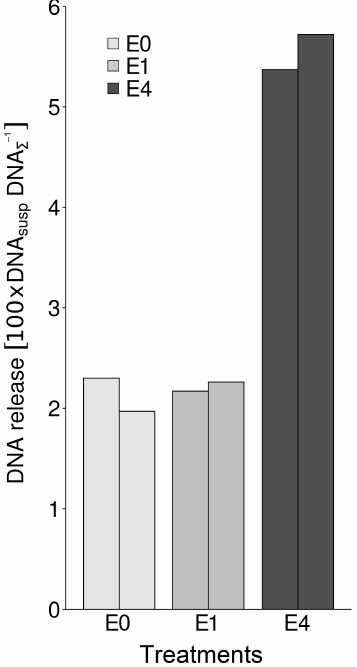
Figure 3. Relative bacterial DNA release from soil aggregates after treatments E0, E1 and E4 defined as 100 × ratio of bacterial DNA from suspended cells (DNAsusp) to total bacterial DNA from sus- pended cells, sessile cells (DNA (cid:54) ) and the EPSs remaining upon the soil